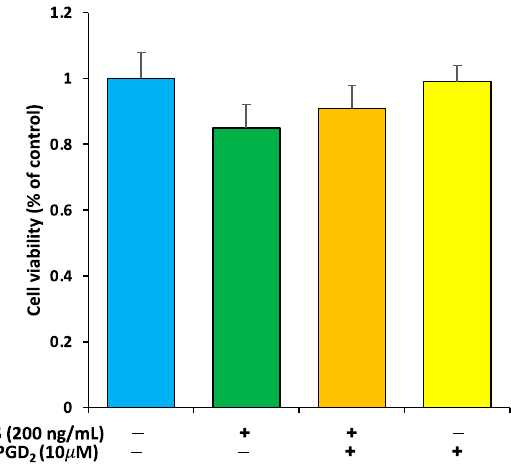
Figure 1. RAW264.7 macrophage cell viability in the presence of LPS and PGD 2 treatments. The treatment of RAW264.7 cells was performed with LPS (200 ng/mL) alone and in the presence of PGD 2 (10 µ M) for 24 h. MTT colorimetric assay was used to check the cell viability.